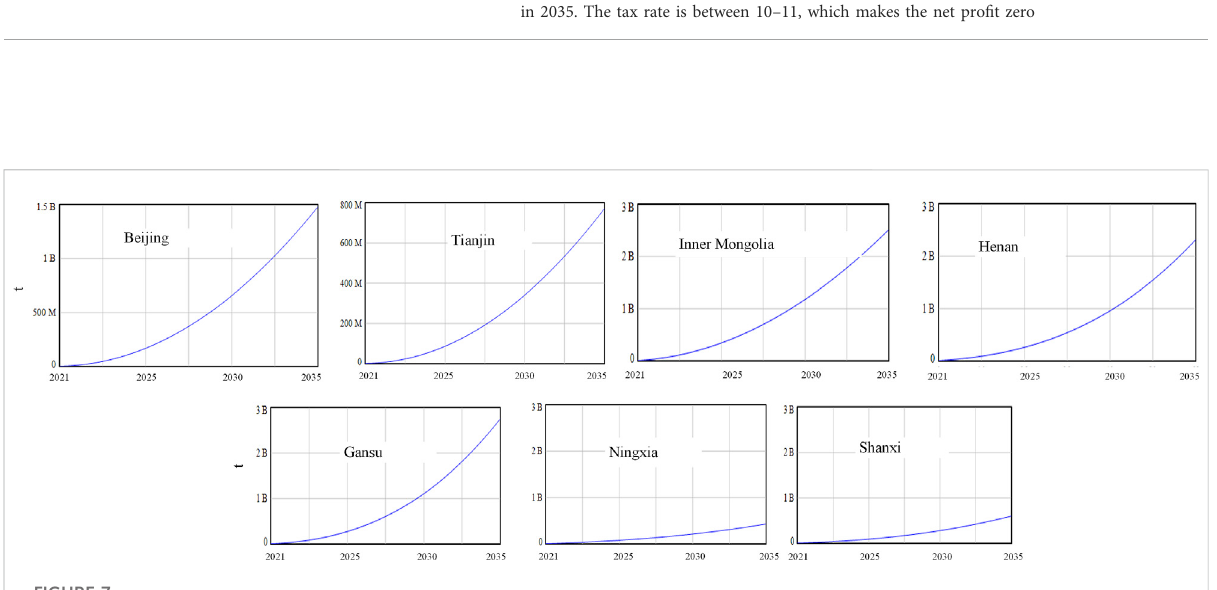
FIGURE 7 BAU scenario of CO 2 emission reduction in central heating provinces and